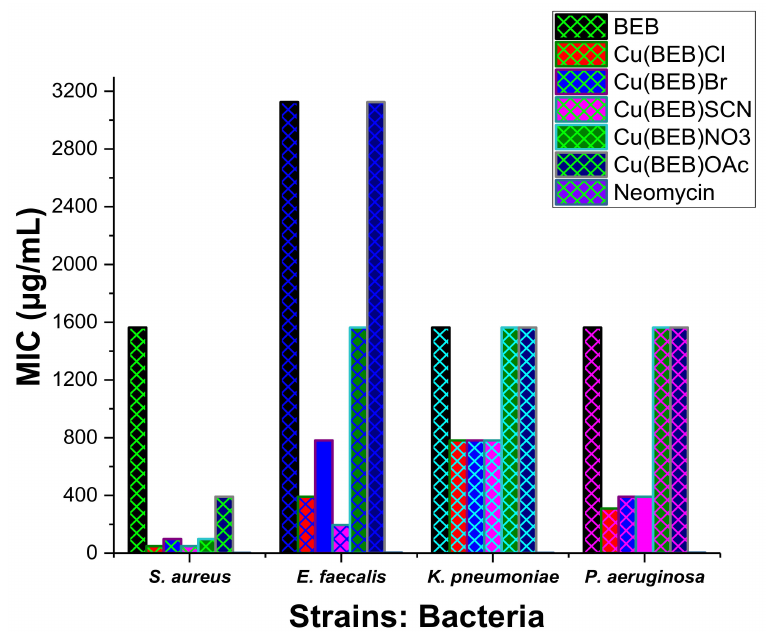
Figure 7. Antibacterial activity (MICs) of the Schiff base (BEB) and its Cu(II) complexes. All the complexes exhibited antifungal activity with MIC value of 48.83 µ g/mL against C. albicans and C. neoformans (fungal strains), comparable to amphotericin B (an antifungal drug) except [Cu(BEB)OAc] with MIC value of 195.3 µ g/mL (Table 5). The in vitro antifungal activity